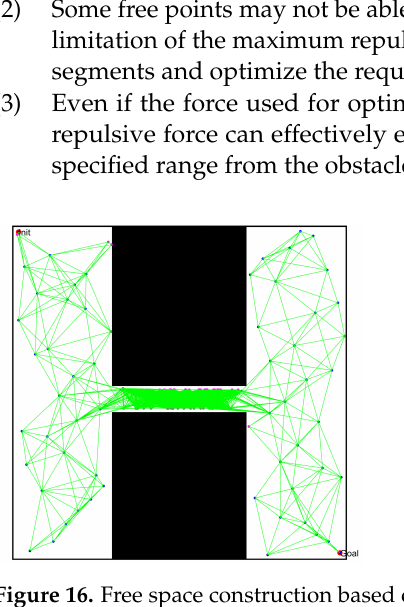
Figure 16. Free space construction based on the typical PRM algorithm.